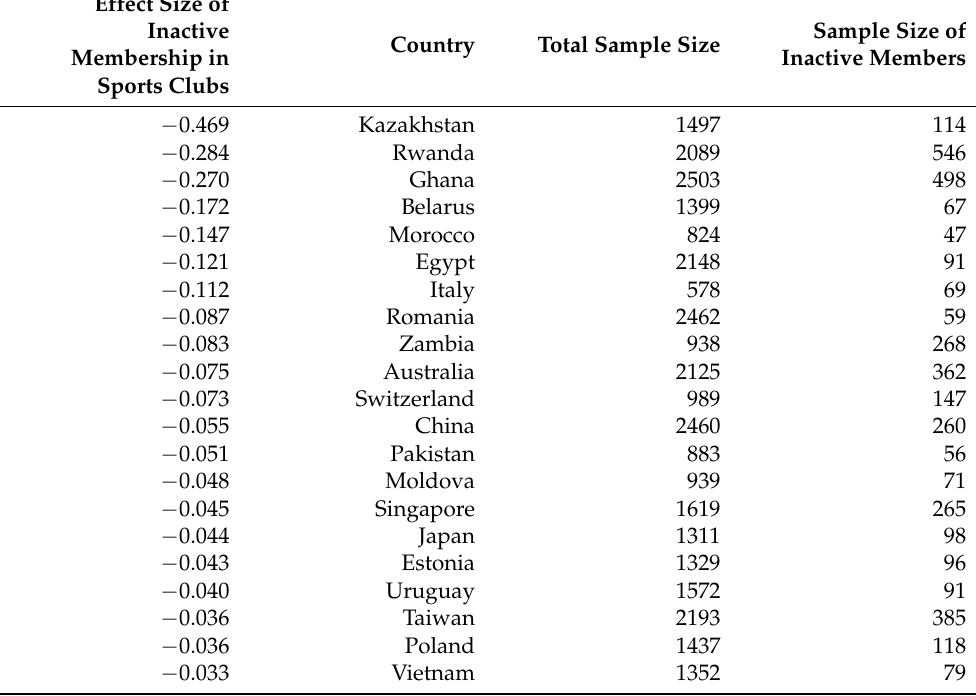
Table A8. List of country-specific effects for inactive membership in sports clubs on sexist gender ideologies for the group of women. Source: WVS-EVS